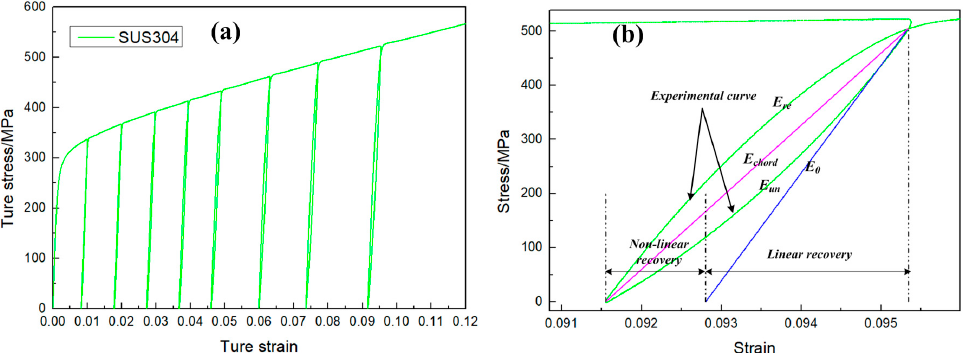
Figure 3. Results of uniaxial loading–unloading–loading tensile test. ( a ) The testing curve ( b ) Display of the chord modulus.